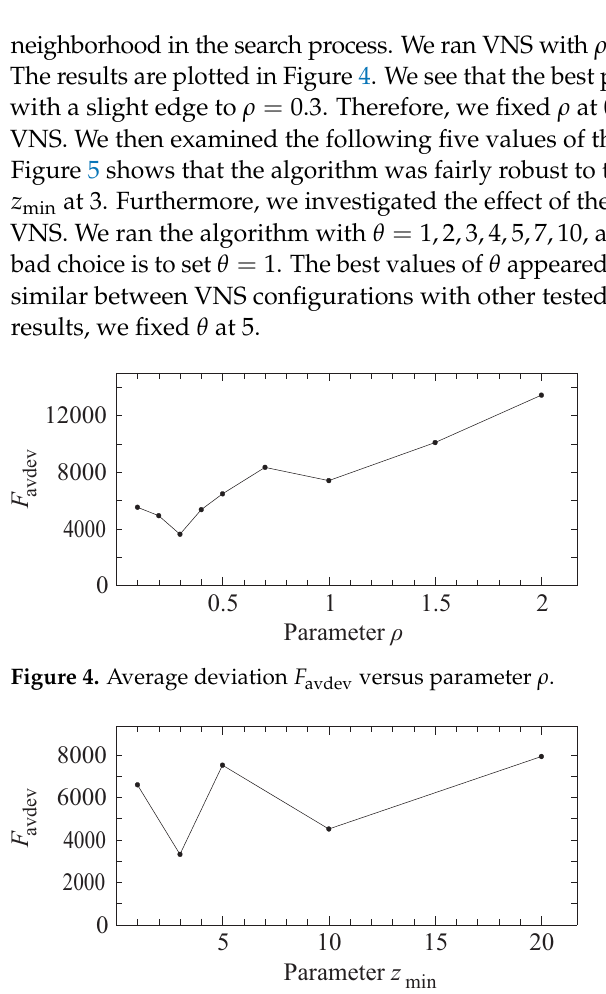
Figure 5. Average deviation F avdev versus parameter z min .